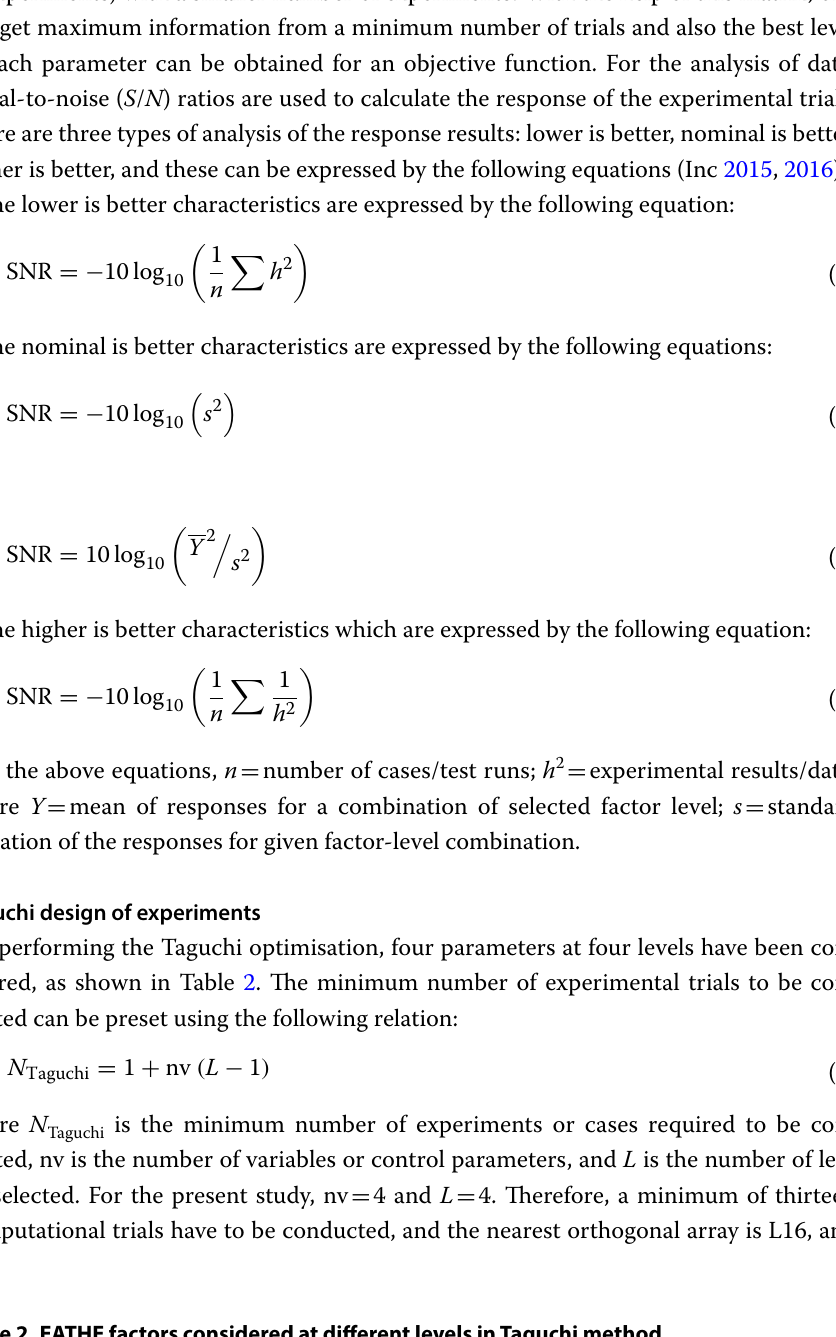
Table 2 EATHE factors considered at different levels in Taguchi method Factor Parameter Level L1 L2 L3 L4 A Diameter of pipe (m) 0.10 0.15 0.20 0.25 B Length of pipe (m) 30 40 50 60 C Inlet air velocity (m/s) 2 3 4 5 D Inlet air temperature (K) 307.35 311.35 315.35